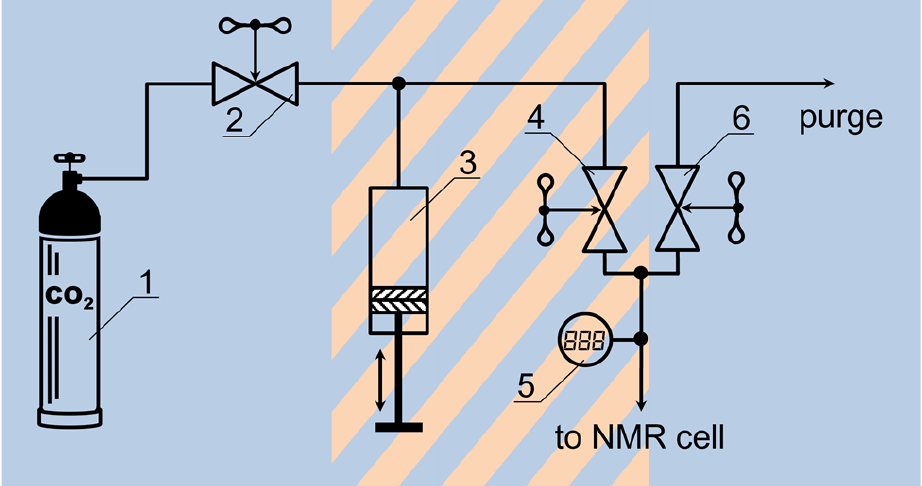
Figure 8. Scheme of the setup for high-pressure NMR experiments at supercritical parameters of state. It consists of a cylinder with carbon dioxide (1), needle valves (2, 4, and 6), a syringe pump (3), and an electronic pressure sensor (5).